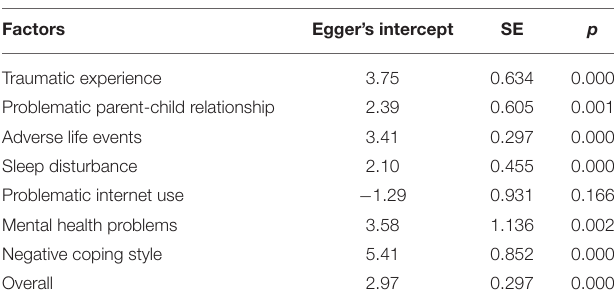
TABLE 3 | Publication bias